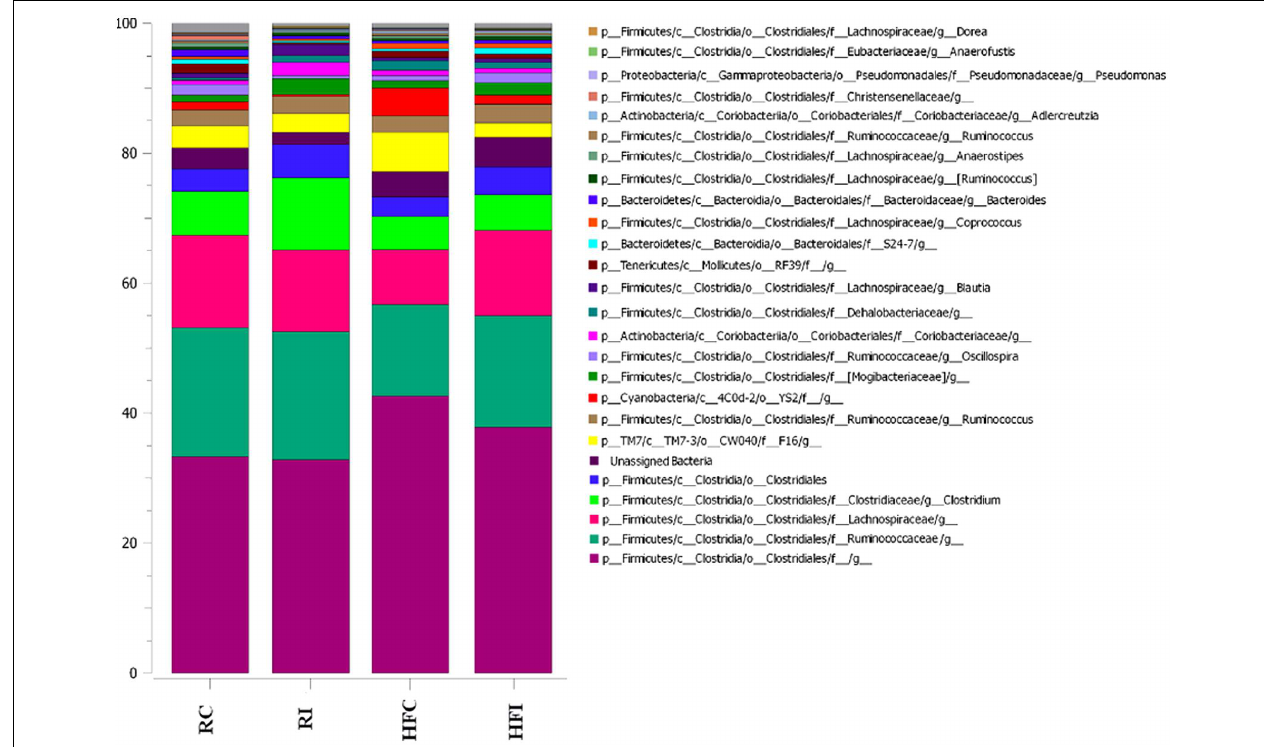
FIGURE 8 | Stack-bar of the most abundant OTUs in sacculus rotundus. Vertical bars demonstrate the proportion (%) of the most abundant bacterial taxa ( > 0.1% of community). Taxonomic classification of each taxon is identified at phylum (p_), class (c_), order (o_), family (f_), and genus (g_)